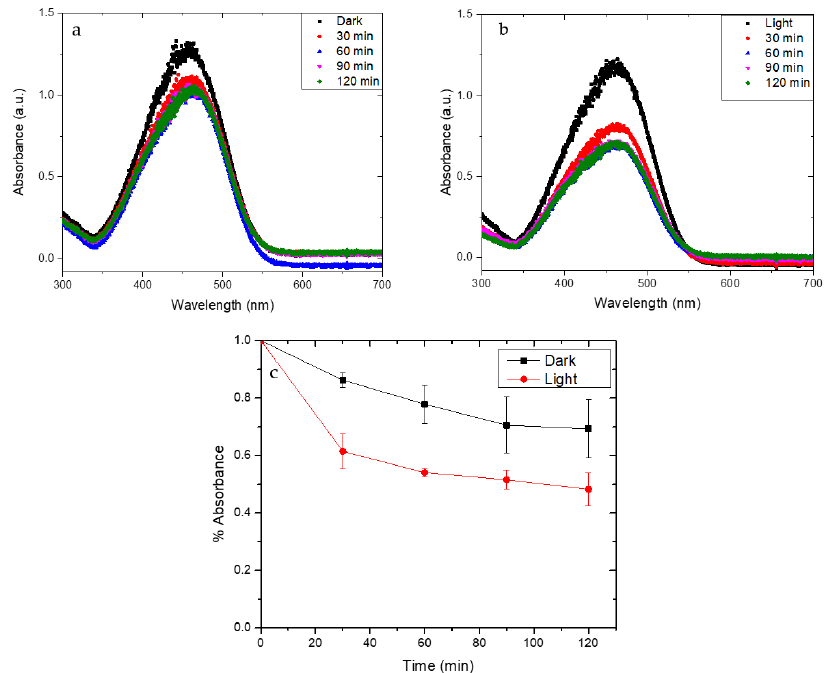
Figure 7. UV spectra under ( a ) dark conditions and ( b ) visible light irradiation. ( c ) Photocatalytic degradation over time of MO using NAM-CuO/Cu 2 O.